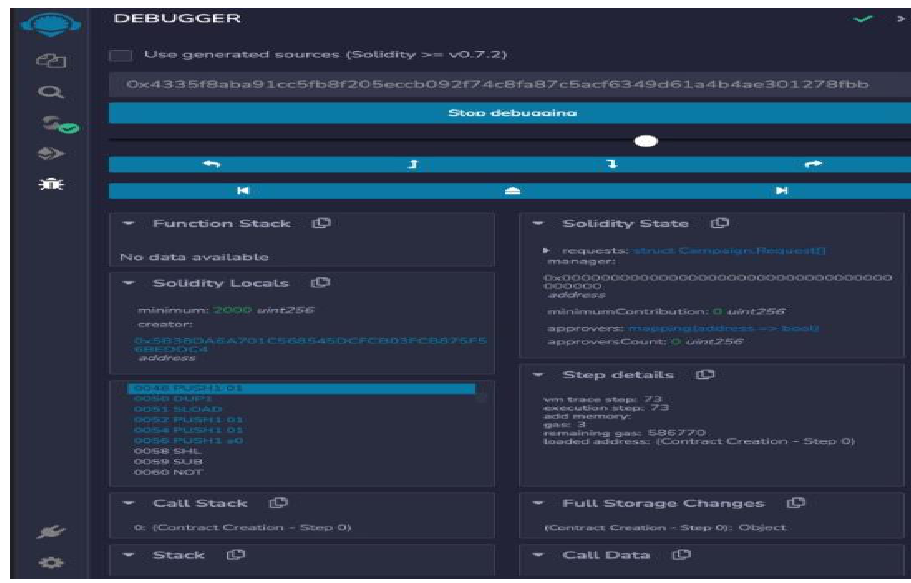
Figure 3. Smart contract deployment.